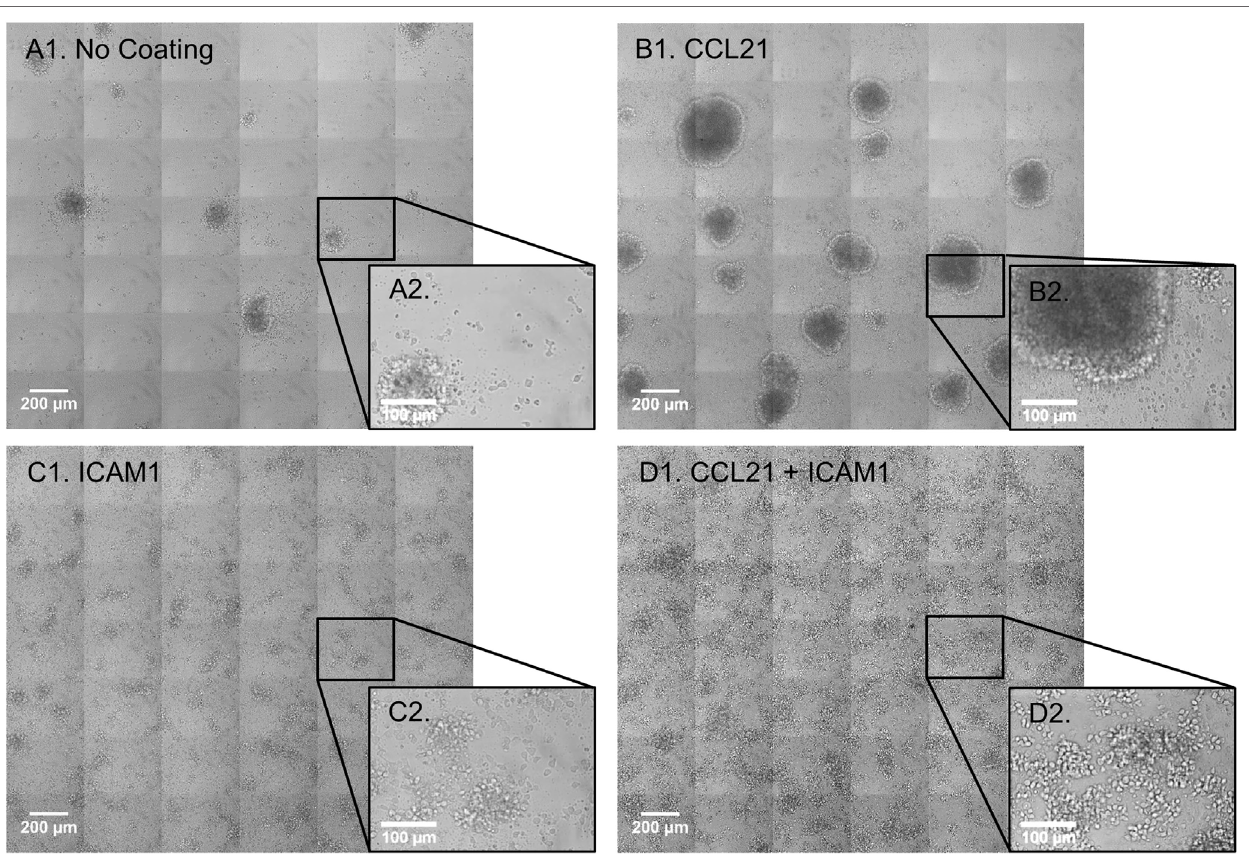
FigUre 1 | Substrate-immobilized CCL21 increases the size of CD8 + T-cell clusters, while substrate-immobilized intercellular adhesion molecule 1 (ICAM1) transforms the clusters into substrate-attached monolayers. (a1–D2) Transmitted light microscopy images depicting morphological changes in co-cultures of OT-I CD8 + T-cells and ovalbumin-loaded dendritic cells (DCs). Primary T-cells and DCs were isolated from spleen and were immediately co-cultured for 72 h, on either an uncoated substrate (a1,a2) , substrate-immobilized CCL21 (B1,B2) , substrate-immobilized ICAM1 (c1,c2) , or substrate-immobilized CCL21 + ICAM1 (D1,D2) . Substrate-immobilized CCL21 (B1,B2) induced larger T-cell clusters compared to the uncoated substrate (a1,a2) , while ICAM1 alone (c1,c2) , or in combination with CCL21 (D1,D2) , induced cell spreading and decreased cluster size. Scale bar in a1 , B1 , c1 , and D1 : 200 µm. Black squares (a2–D2) show enlarged regions, with a scale bar of 100